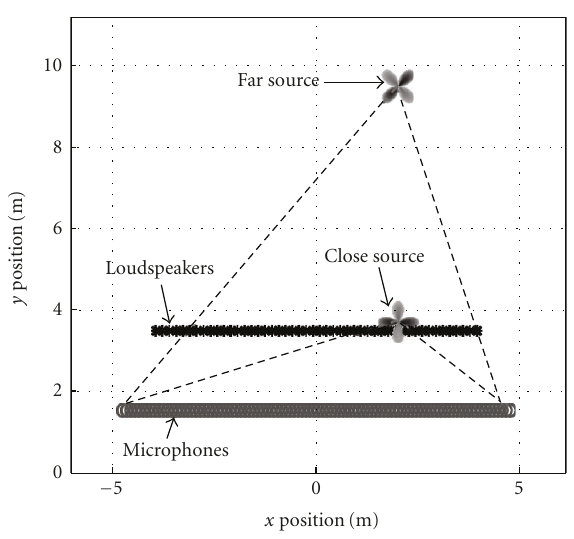
Figure 3: Test configuration, 48-channel loudspeaker array, 96 mi- crophones at 2m, 1 source 20cm behind the array, 1 source 6m behind the